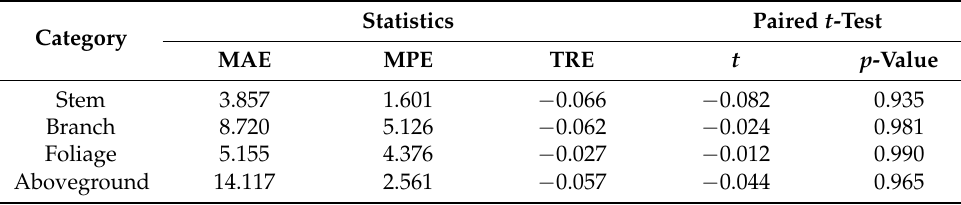
Figure 5. Relationships between observed and predicted biomass values obtained by jackknife procedure. Table 4. Cross-validation statistics for component-specific and total aboveground biomass. Table 4. Cross ‐ validation statistics for component ‐ specific and total aboveground biomass.